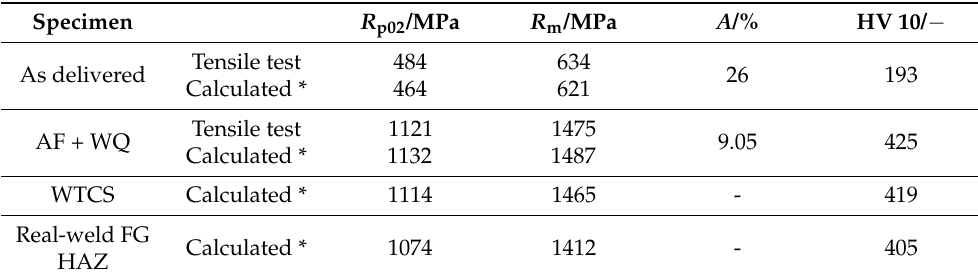
Table 4. Results of tensile tests and hardness